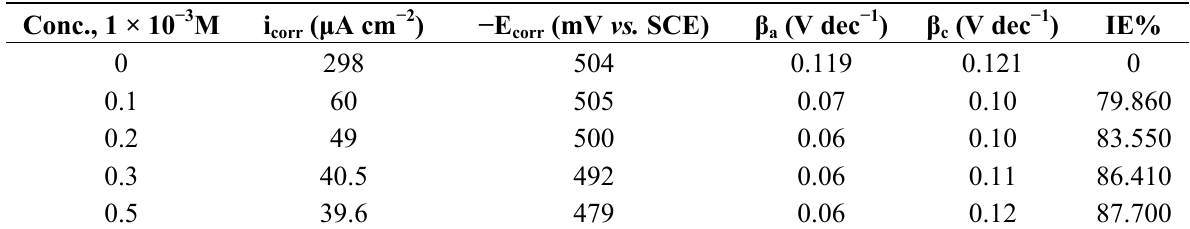
Table 2. Polarization parameters for mild steel in 1.0 M HCl with different concentrations of DMPO at 30 °C.